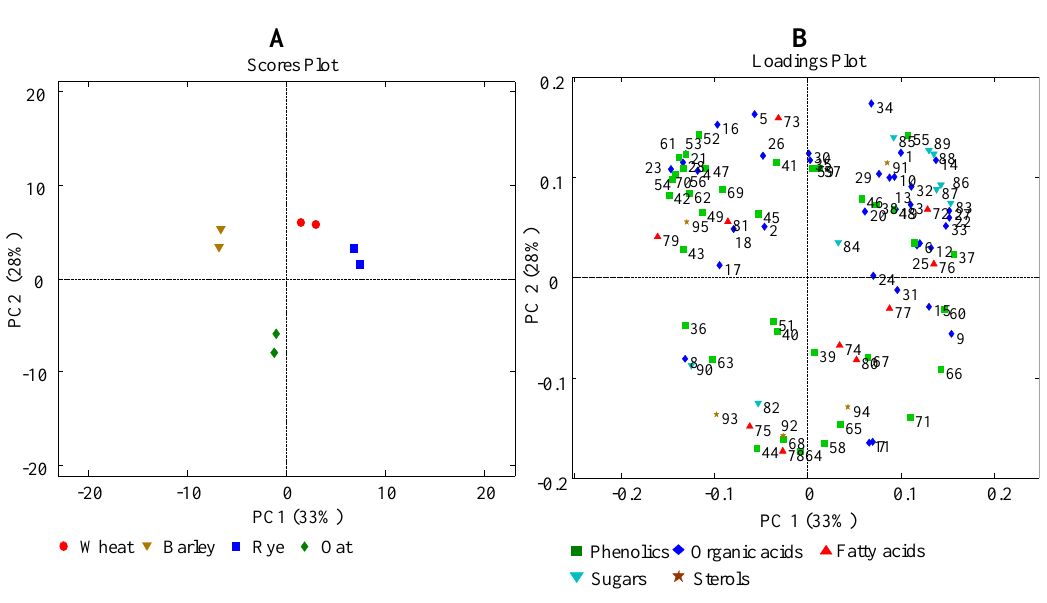
Figure 3. ( A ) scores and ( B ) loading plots of the three component PCA model developed using identified metabolite table. * Numbers in loadings plot correspond to the metabolites represented in Table